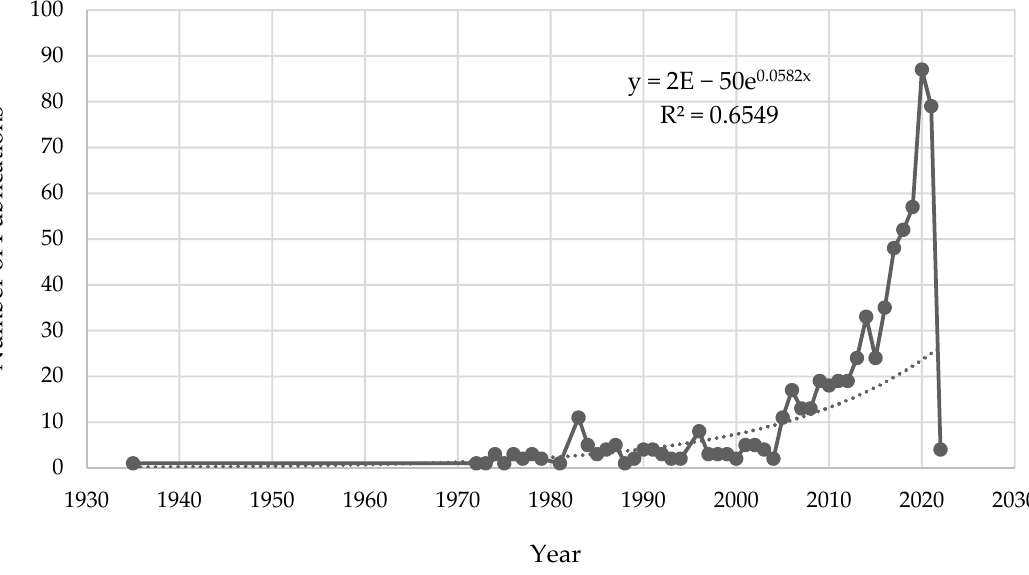
Figure 4. Number of publications on “agricultural wastes used as building materials”.